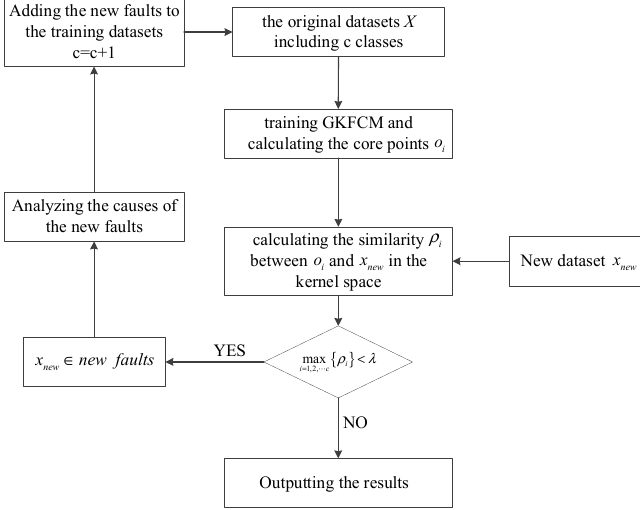
Figure 1. The flow chart of the fault diagnostic method based on Gaussian Kernel Fuzzy C-means clustering method (GKFCM).